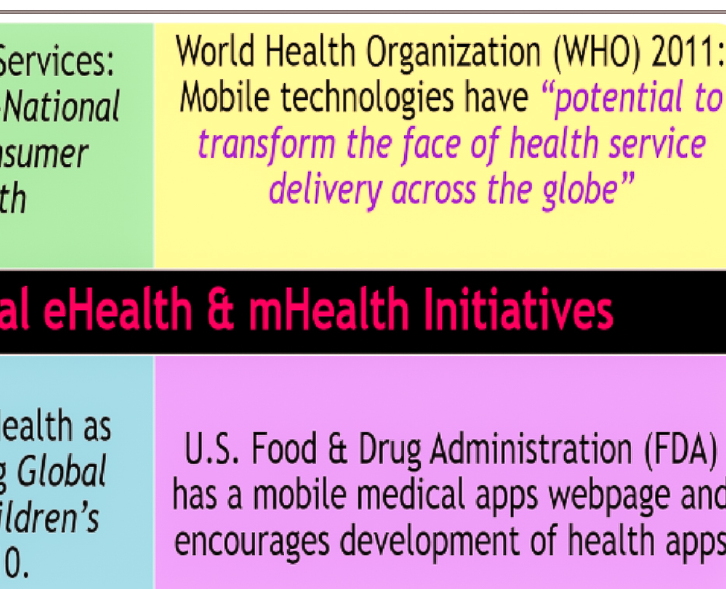
Figure 3. National and global electronic and mobile health